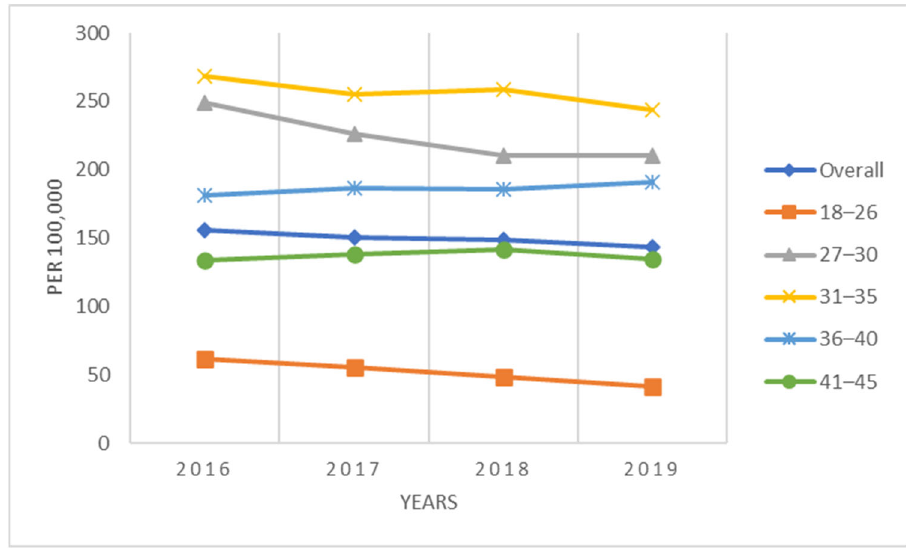
Figure 1. Annual incidence of conization per 100,000 women (2016–2019).